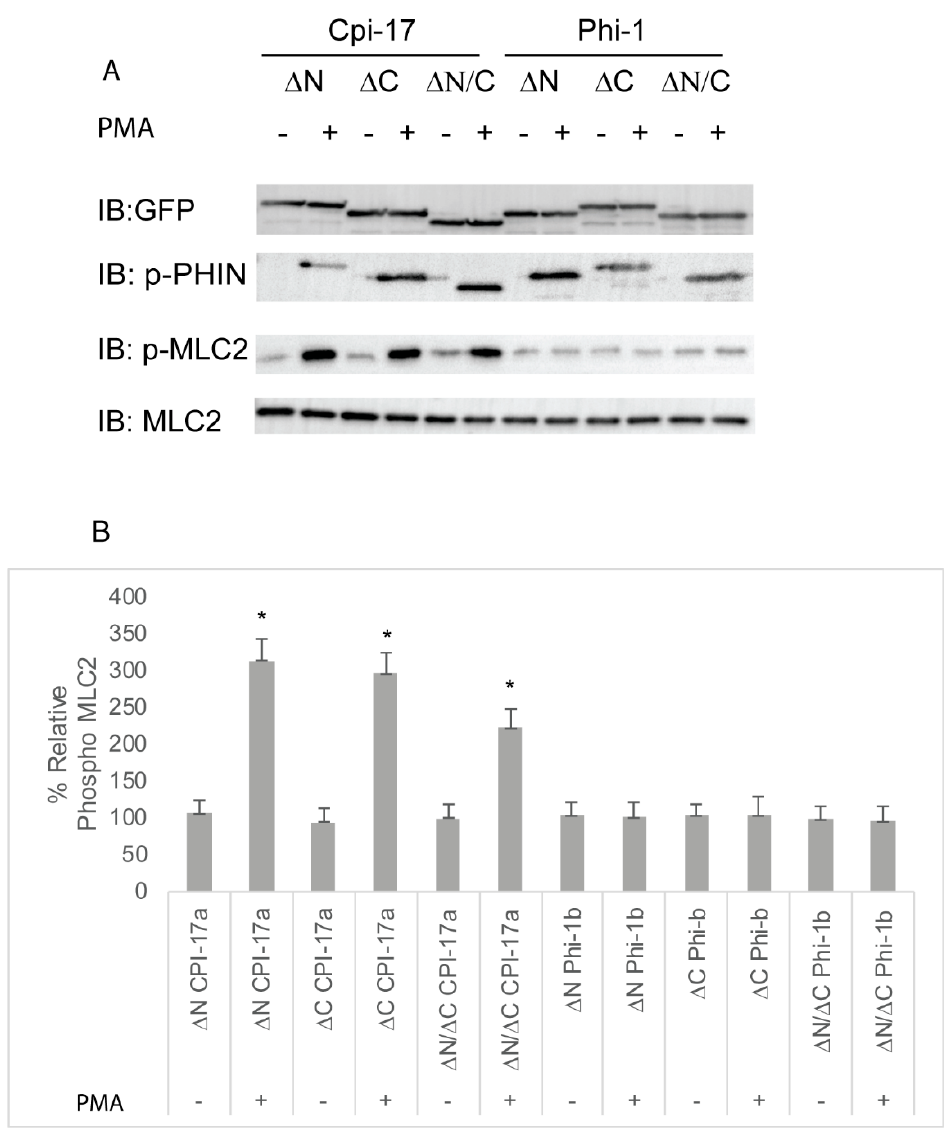
Figure 8. Truncation mutants of Cpi-17 family members highlight the critical role of the PHIN domain in myosin phosphatase inhibition. ( A ) HeLa cells were transfected with either ppp1r14aa lacking the N-terminus ( Δ N), ppp1r14aa lacking the C terminus ( Δ C), ppp1r14aa lacking both the N and C termini ( Δ N/ Δ C) , ppp1r14bb lacking the N-terminus ( Δ N), ppp1r14bb lacking the C-terminus ( Δ C), or ppp1r14bb lacking both the N- and C-termini ( Δ N/ Δ C). Notably, 15 h post transfection cells were treated with either 1 µM PMA or 0.1% DMSO for 3 h, and lysates were blotted with anti-GFP, anti-phospho-PHN, anti-Mlc2, or anti phospho-Mlc2. ( B ) Mlc2 phosphorylation was normalized to total Mlc2 content, and is shown as fold change compared with cells expressing the empty GFP-vector. Error bars indicate standard error, and an * indicates a statistically significant difference from control. Statistical significance was calculated using a one-factor ANOVA with Holm–Šídák post-hoc analysis and is defined as p < 0.05 from at least four biological replicates.